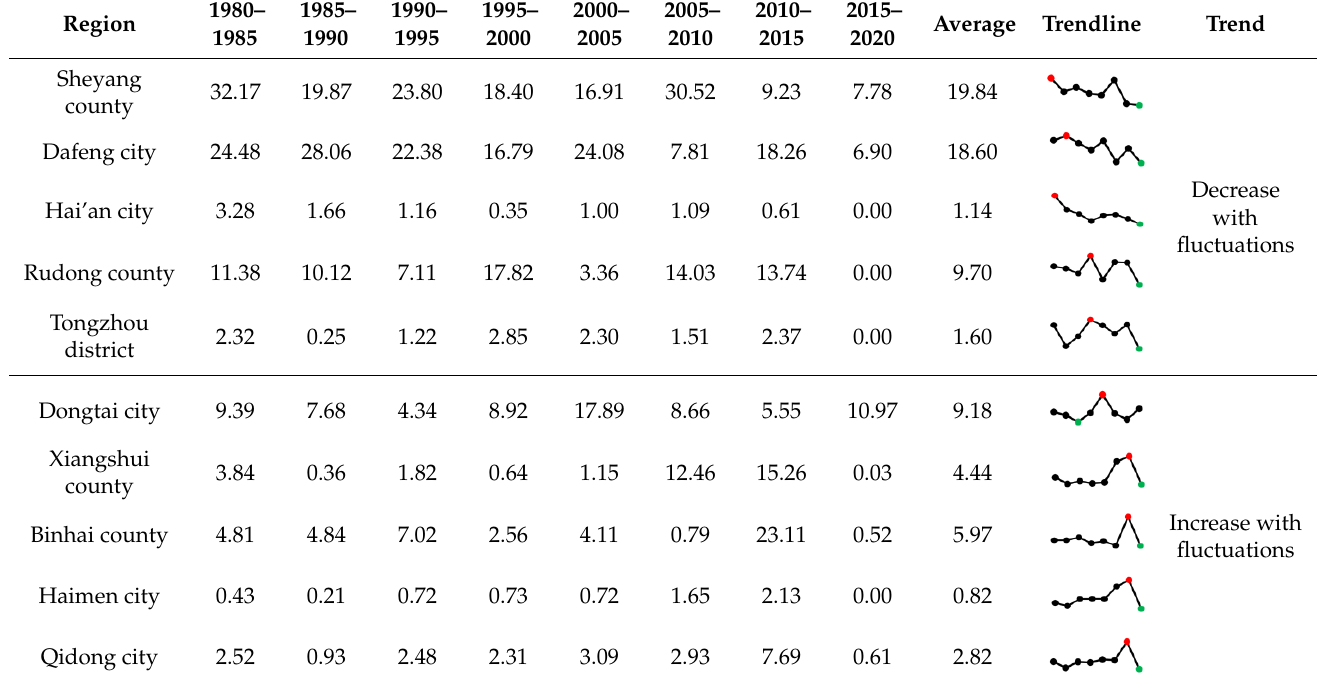
Considering the trends for the rates of degradation and recovery evolution in the eight periods, the 10 counties and cities were classified into four categories: decreasing– decreasing trend (rate of degradation with a decreasing trend and recovery evolution with